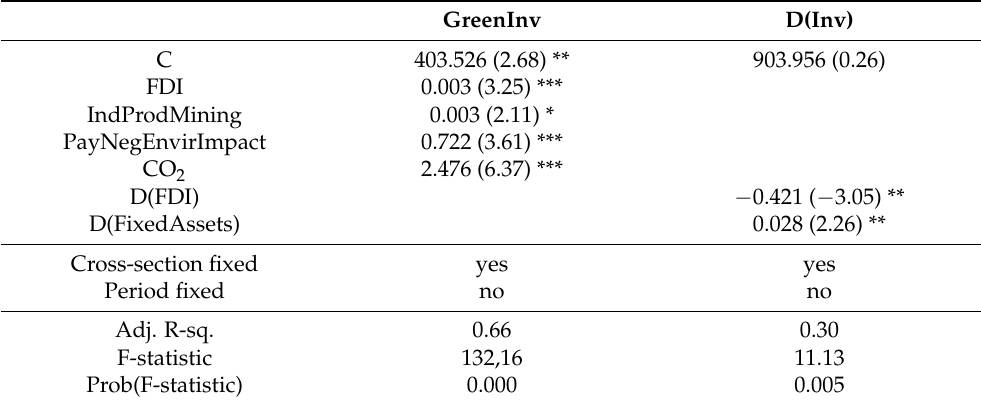
Table 5. Assessment results (*** p < 0.01; ** p < 0.05; * p <